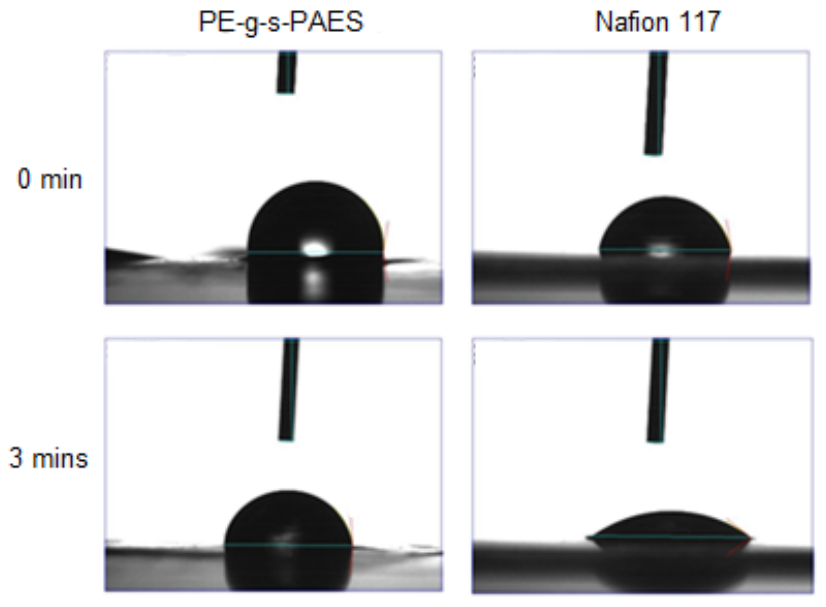
Figure 2. Comparison of water drop on PE-g-s-PAES and Nafion 117